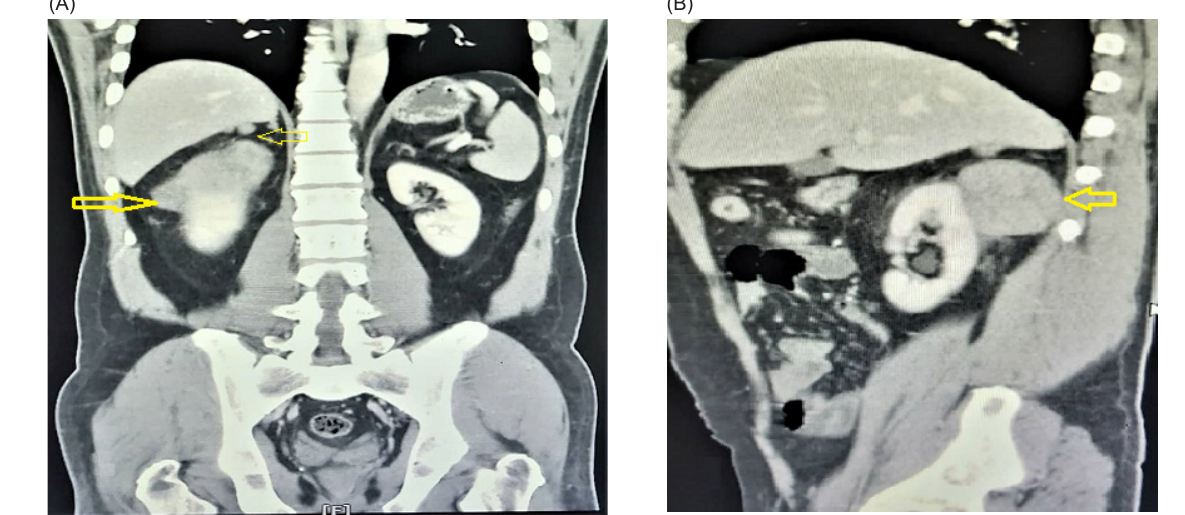
FIGURE 1: A computerized tomography (CT) scan showed: (A) Mass in the right kidney (arrow), two masses were attached to the liver tightly (arrow). (B) Oblique view of mass in the right kidney with low enhancement